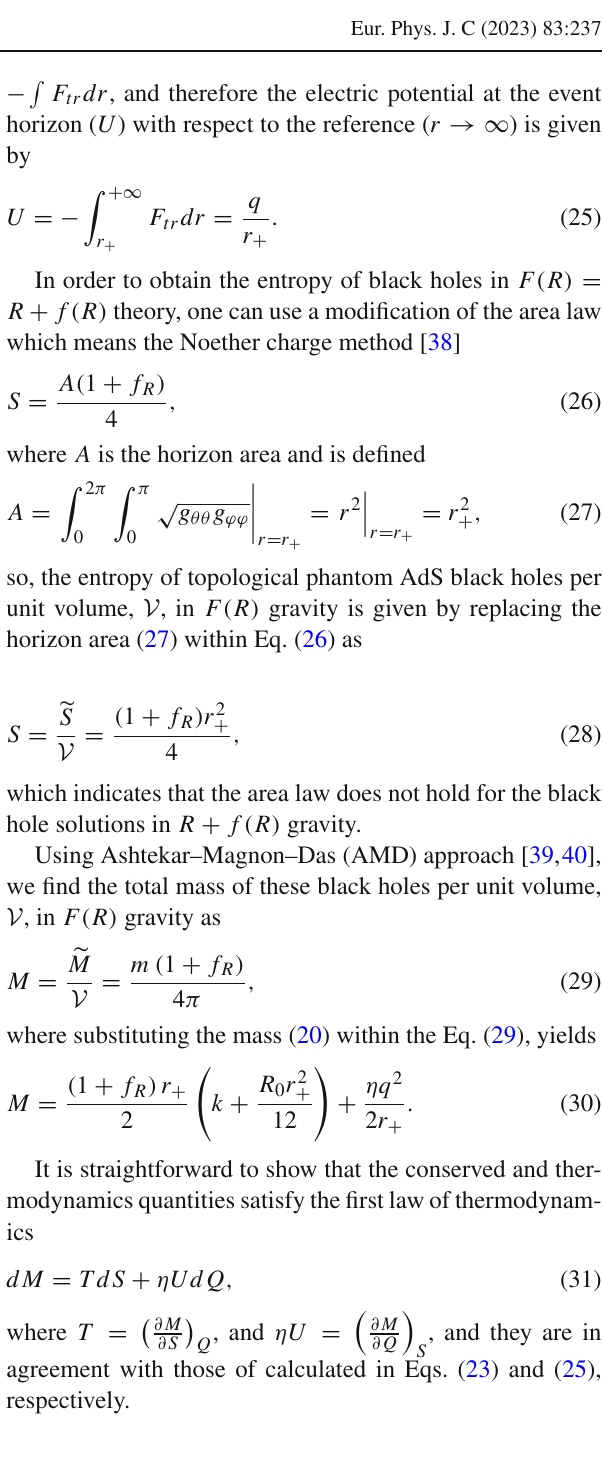
Fig. 1 The metric function g ( r ) versus r for different values of the parameters. Left panels for η = 1, and right panels for η = − 1